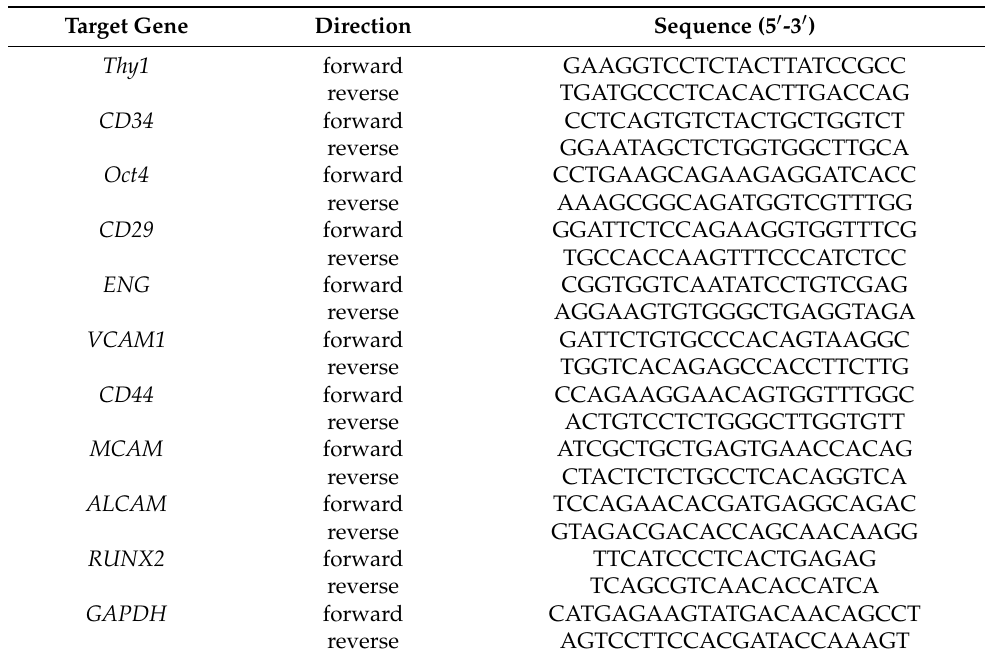
Table 2. RT-qPCR primer